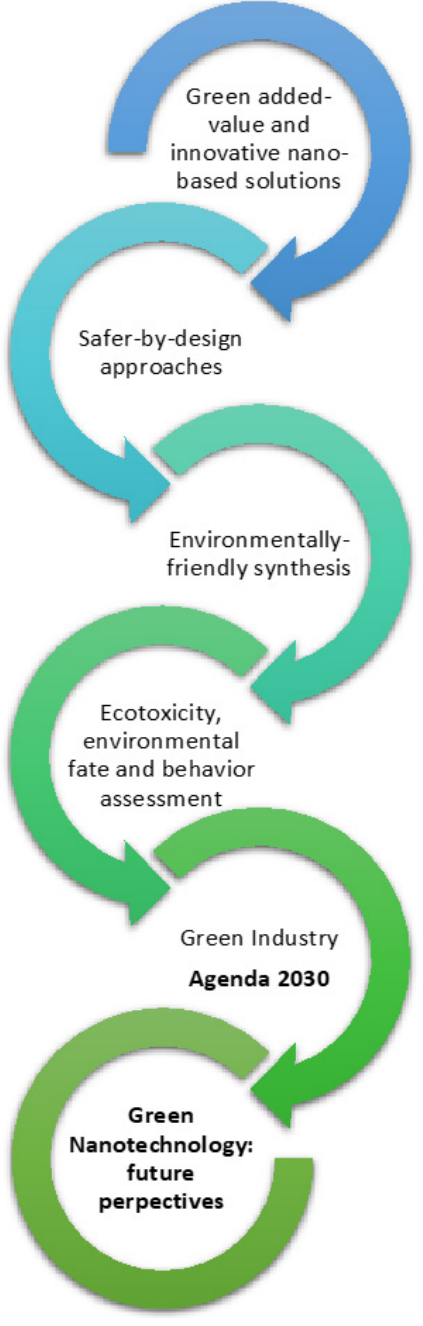
Figure 2. Future perspectives on the field of green